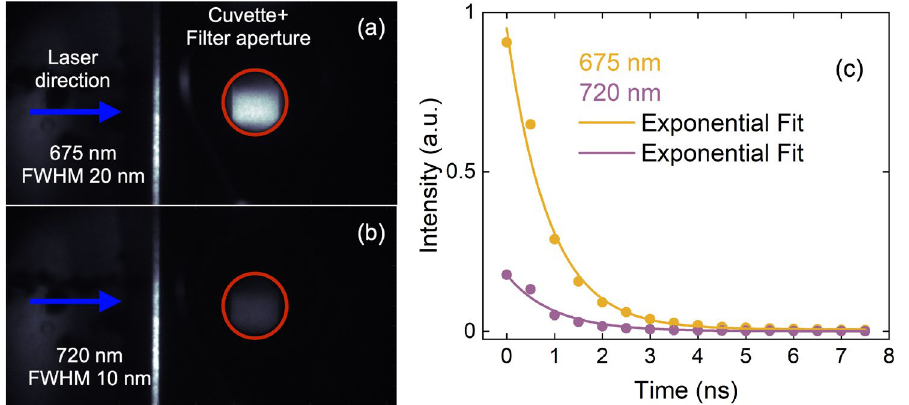
Figure 2. Fluorescence images recorded with the ( a ) 675-nm BPF and ( b ) 720-nm BPF. The red outlines define the region over which the total fluorescence intensity is integrated. Temporal profile of the two peaks ( c ), where the initial delay is 0 ns, the time step is 0.5 ns, and the gate width is 4 ns.